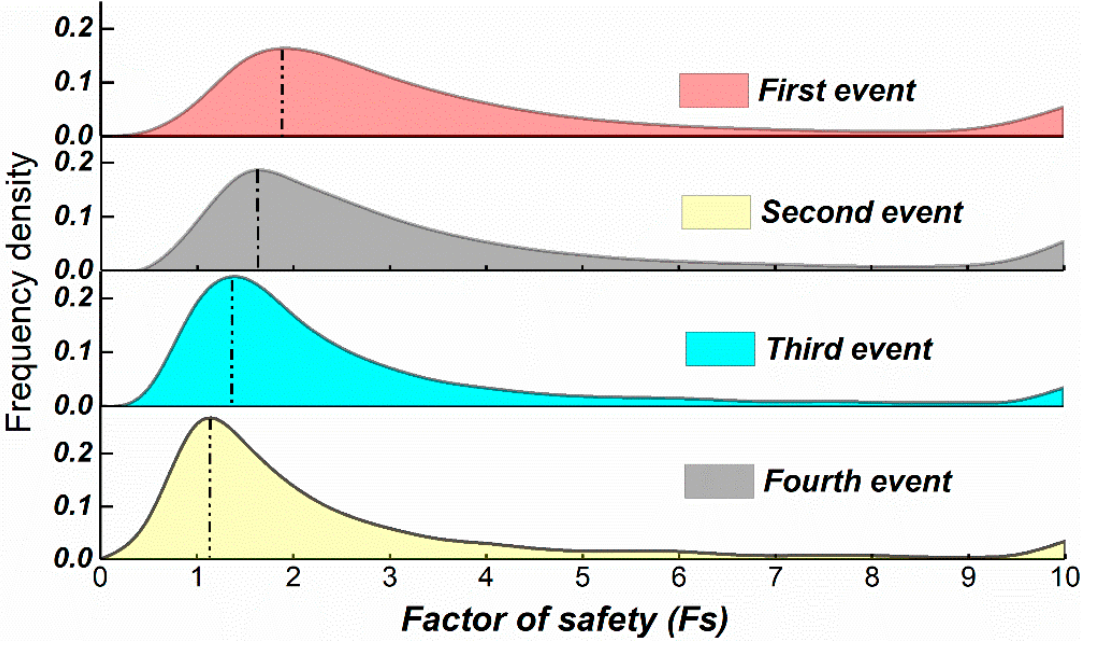
Figure 12. Frequency density distribution of the factor of safety (Fs) under four rainfall events.